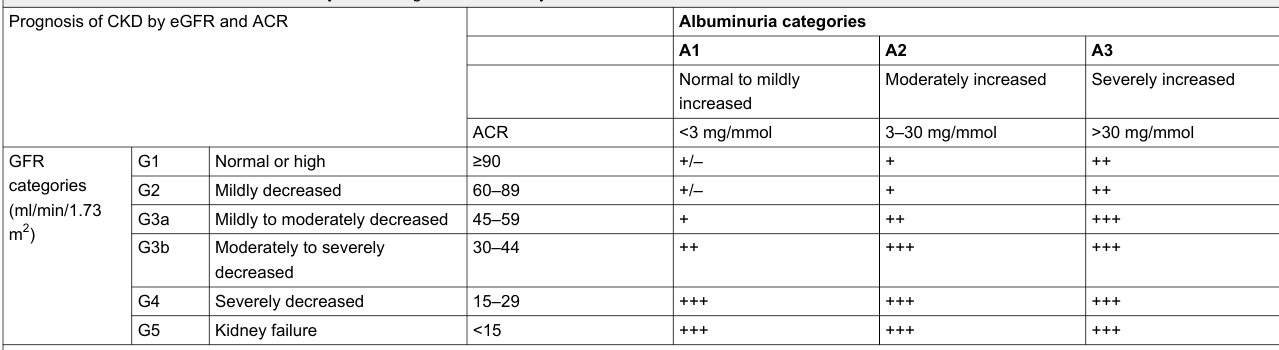
Table 1: KDIGO 2012 CKD classification by GFR categories and urinary albumin/creatinine